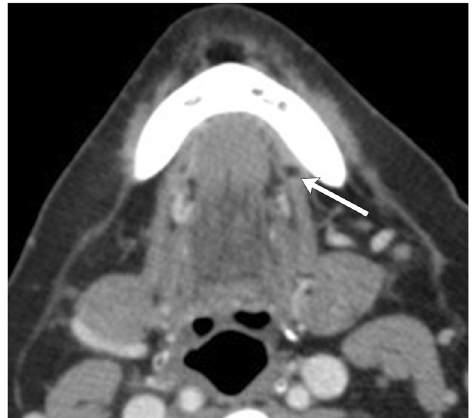
Fig. 17 Mylohyoid slit (boutonniere). Axial contrast-enhanced CTimage shows a linear, fat-containing defect within the mylohyoid muscle at the anterior aspect ( arrow )